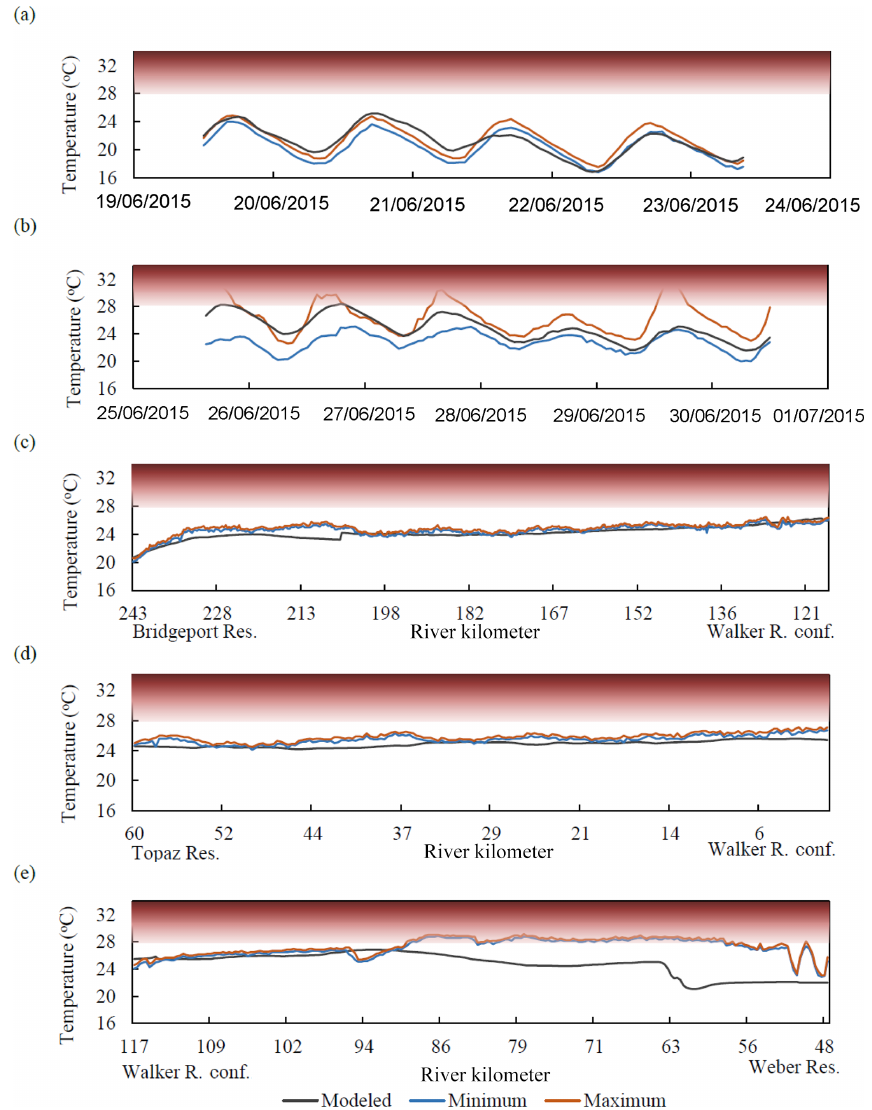
Figure 7. Hourly minimum and maximum DTS site temperatures compared to model predictions in the East Walker River (a) and main stem Walker River (b) (Wabuska Drain temperatures are not included as they were not modeled). July 2012 minimum and maximum TIR temperatures calculated for every 300m model reach length compared to modeled temperatures for East Walker (c) , West Walker (d) , and main stem Walker (e) rivers. The upstream end of Weber Reservoir is river kilometer 48. The river flows from left to right in (c–e) . Shaded region shows temperatures exceeding the 28 ◦ C lethal threshold for